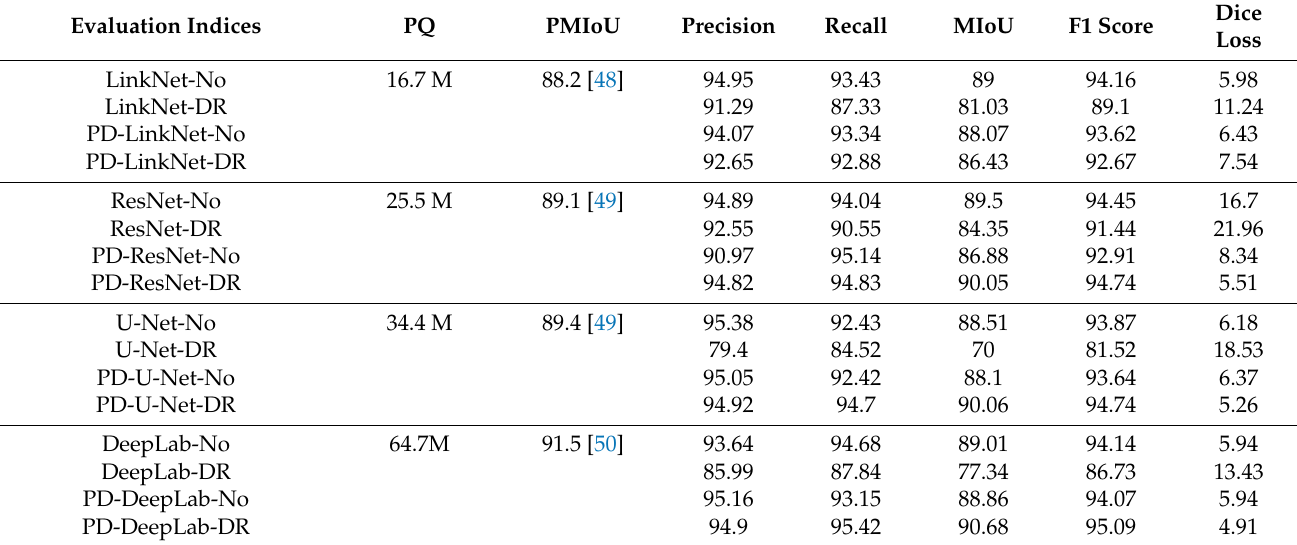
Table 1. Evaluation results of the network (Unit: %, keep two